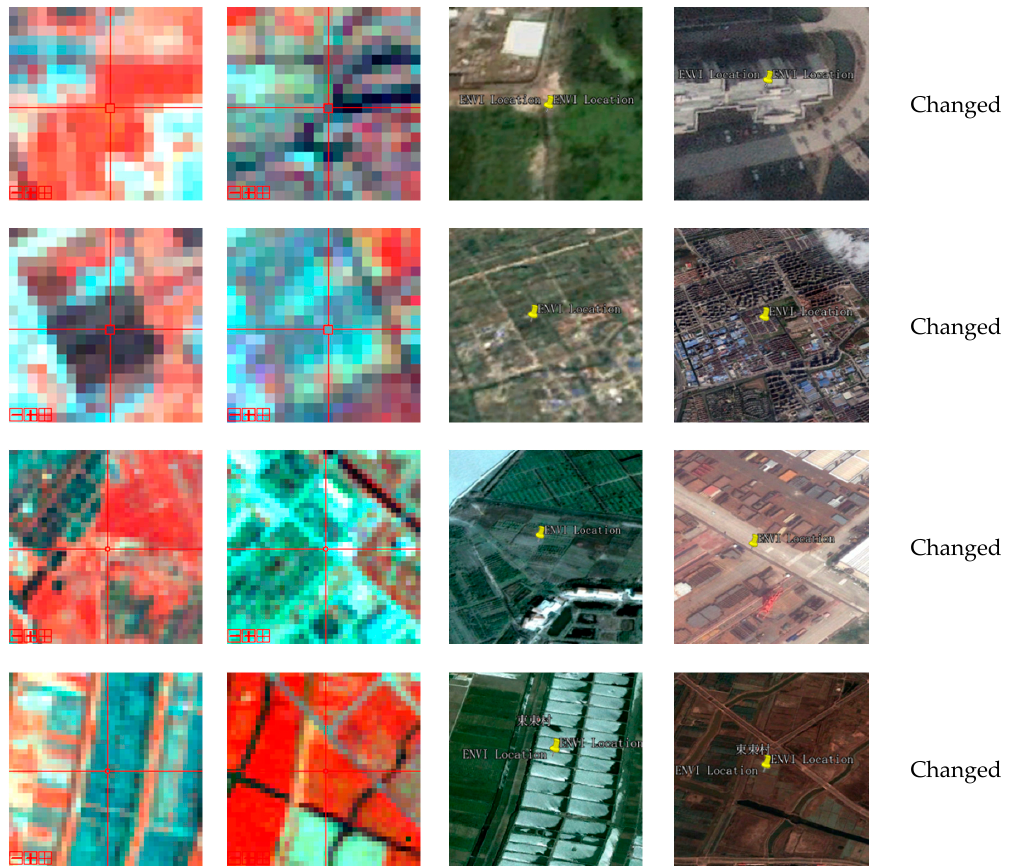
Figure 6. Examples of check points in 30 m Landsat imagery and Google Earth.